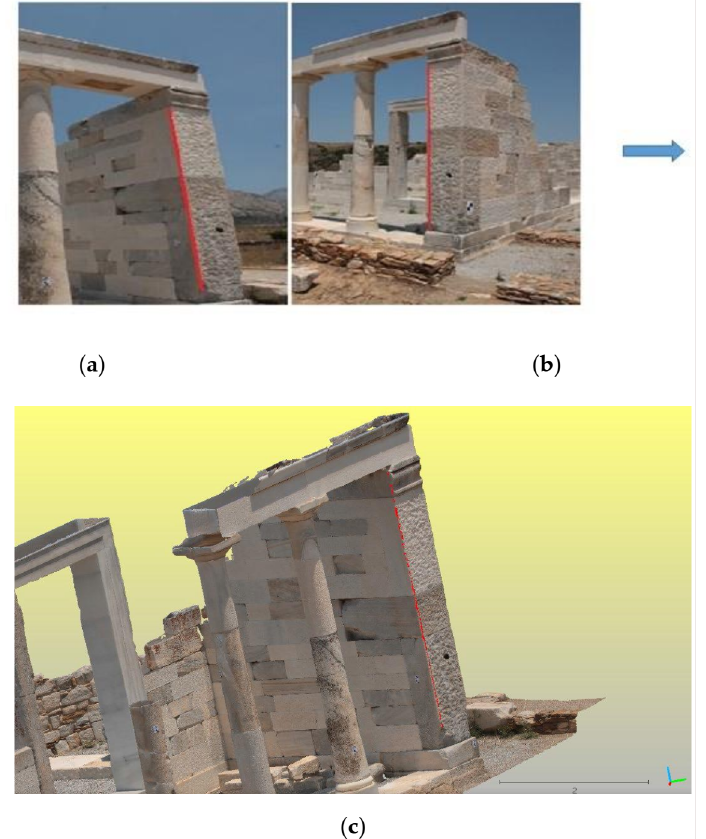
Figure 14. Edges depicted frontally with both sides imaged ( a ) or just one side ( b ). Result of successful localization of edge ( c ) obtained using ( b